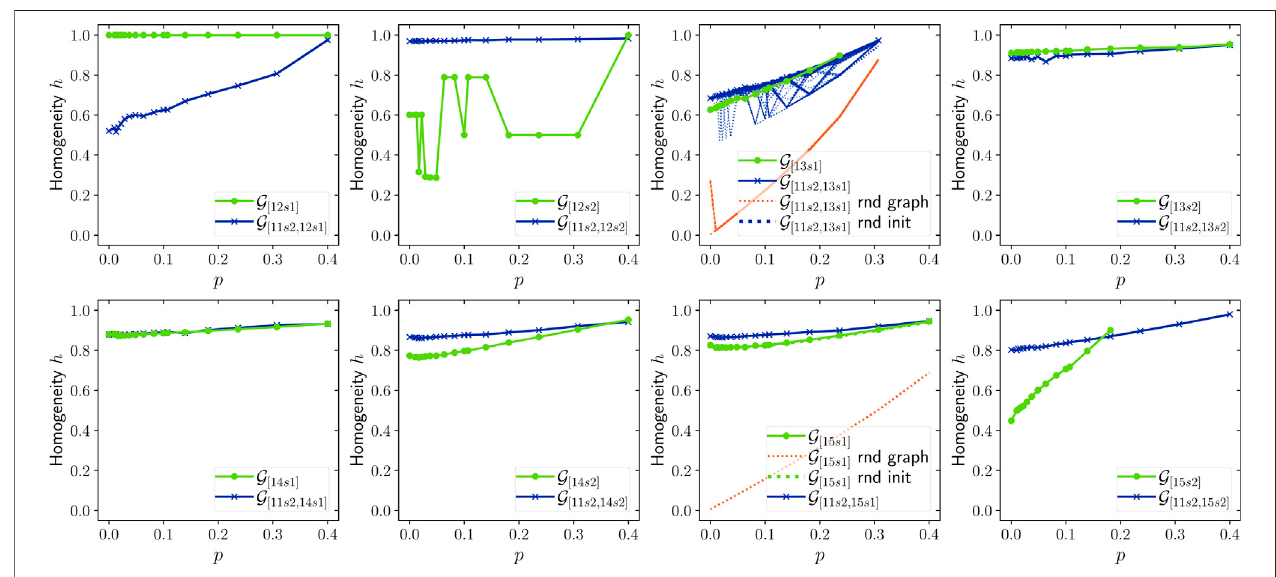
FIGURE 11 | Homogeneity as a function of p .